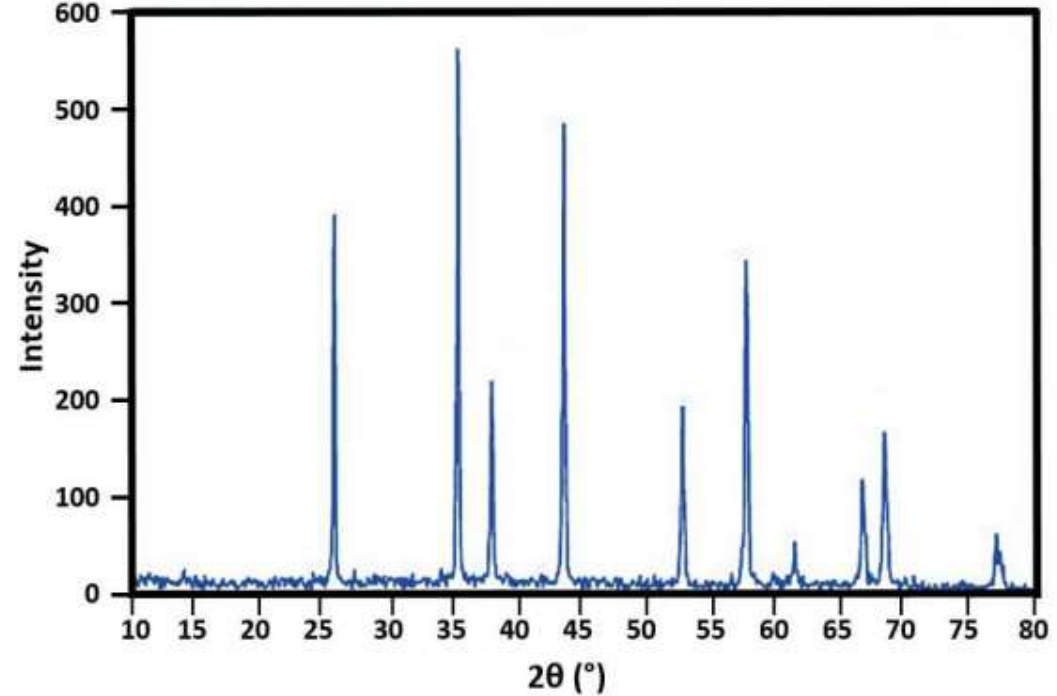
Figure 2: XRD pattern of synthesized